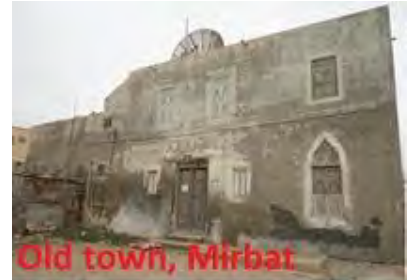
Figure 10. Fac¸ade’s photograph building location